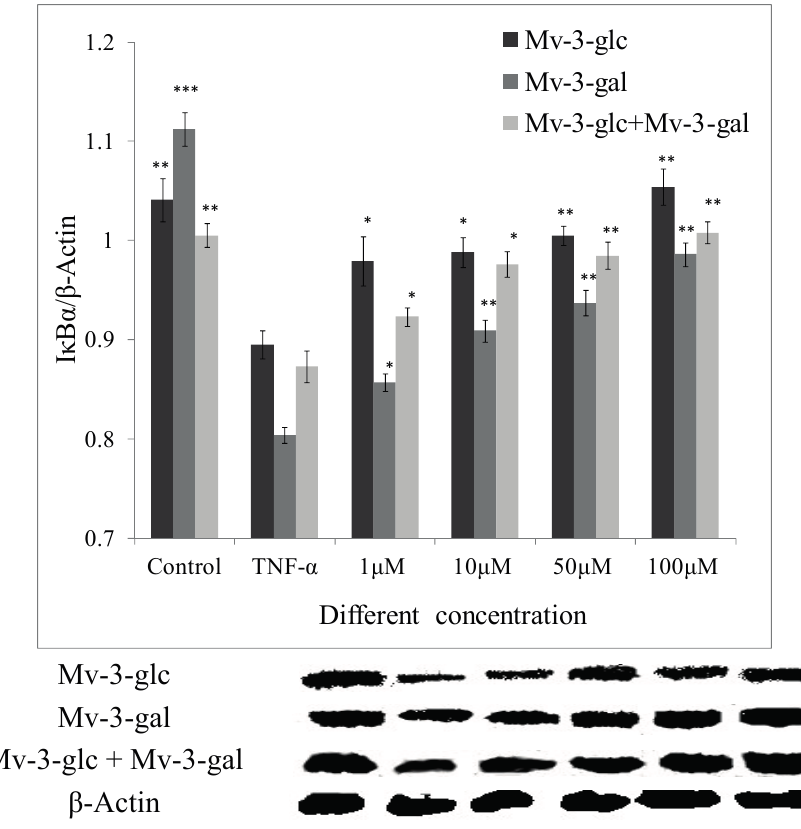
Figure 4. Effects of Mv-3-glc, Mv-3-gal, and their mixture (Mv-3-glc + Mv-3-ga) on I κ B α protein levels in endothelial cells. *, **, and *** indicate p < 0.05, p < 0.01, and p < 0.001 respectively compared to TNF- α